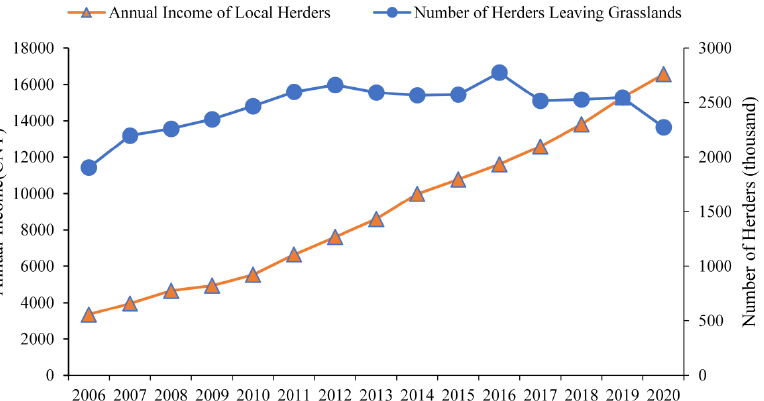
Figure 2. Number of herders leaving grasslands and annual income of herders in Inner Mongolia from 2006 to 2020.